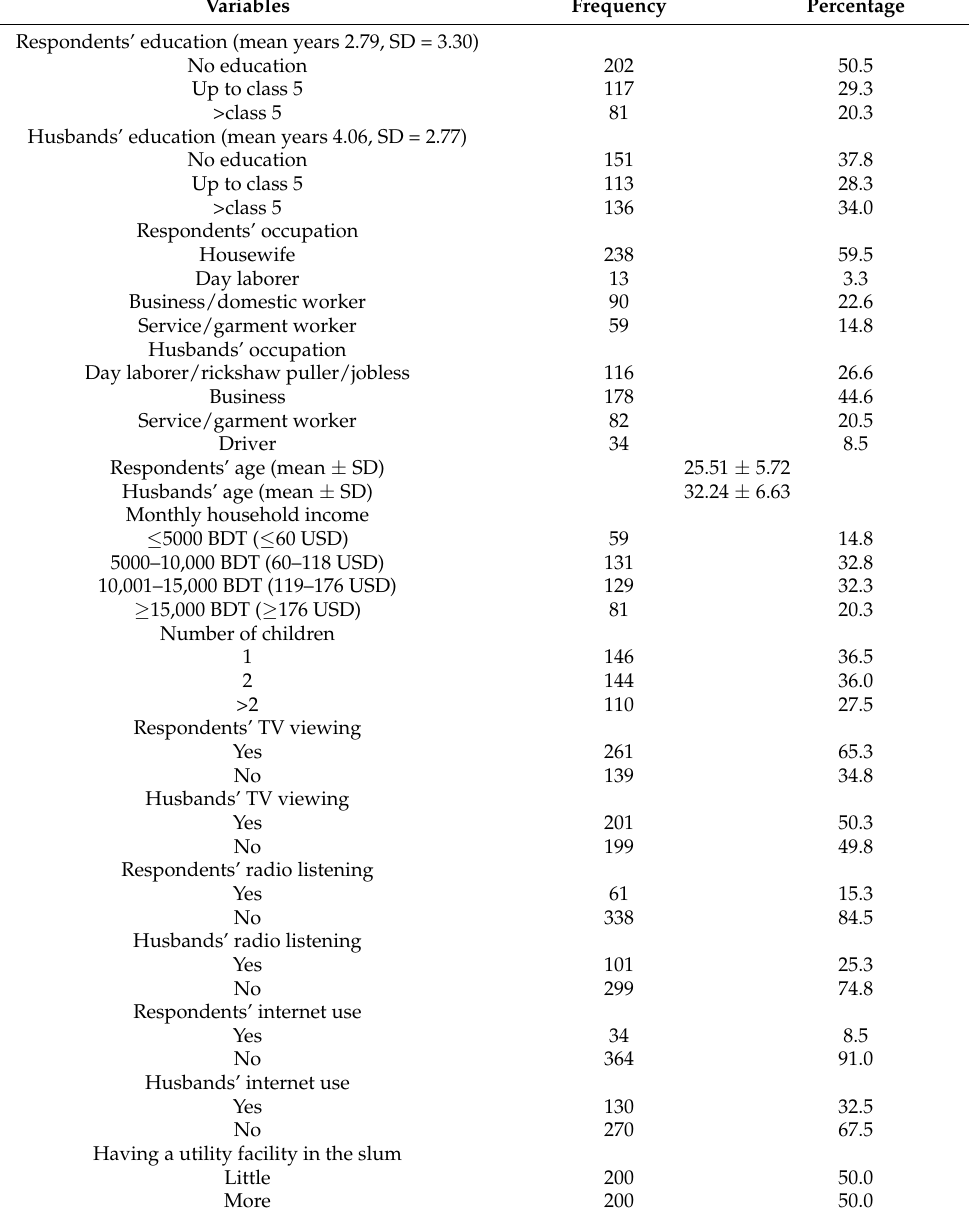
Table 1. Distribution of the socio-demographic characteristics of respondents and their